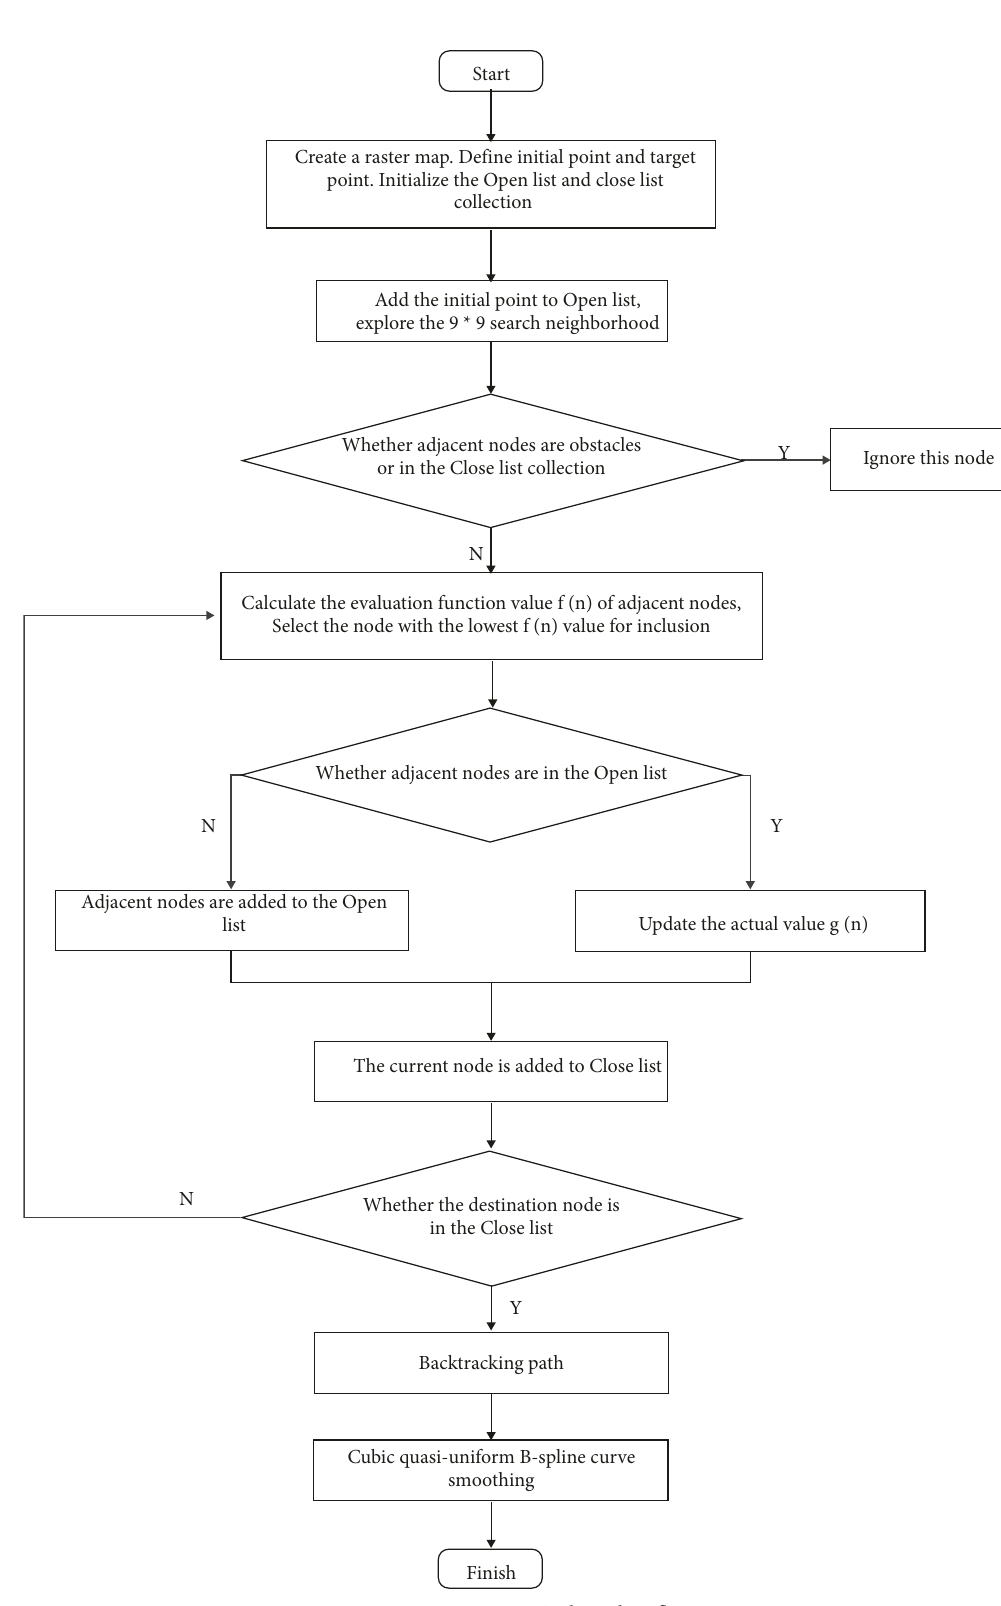
Figure 13: Improve A ∗ algorithm